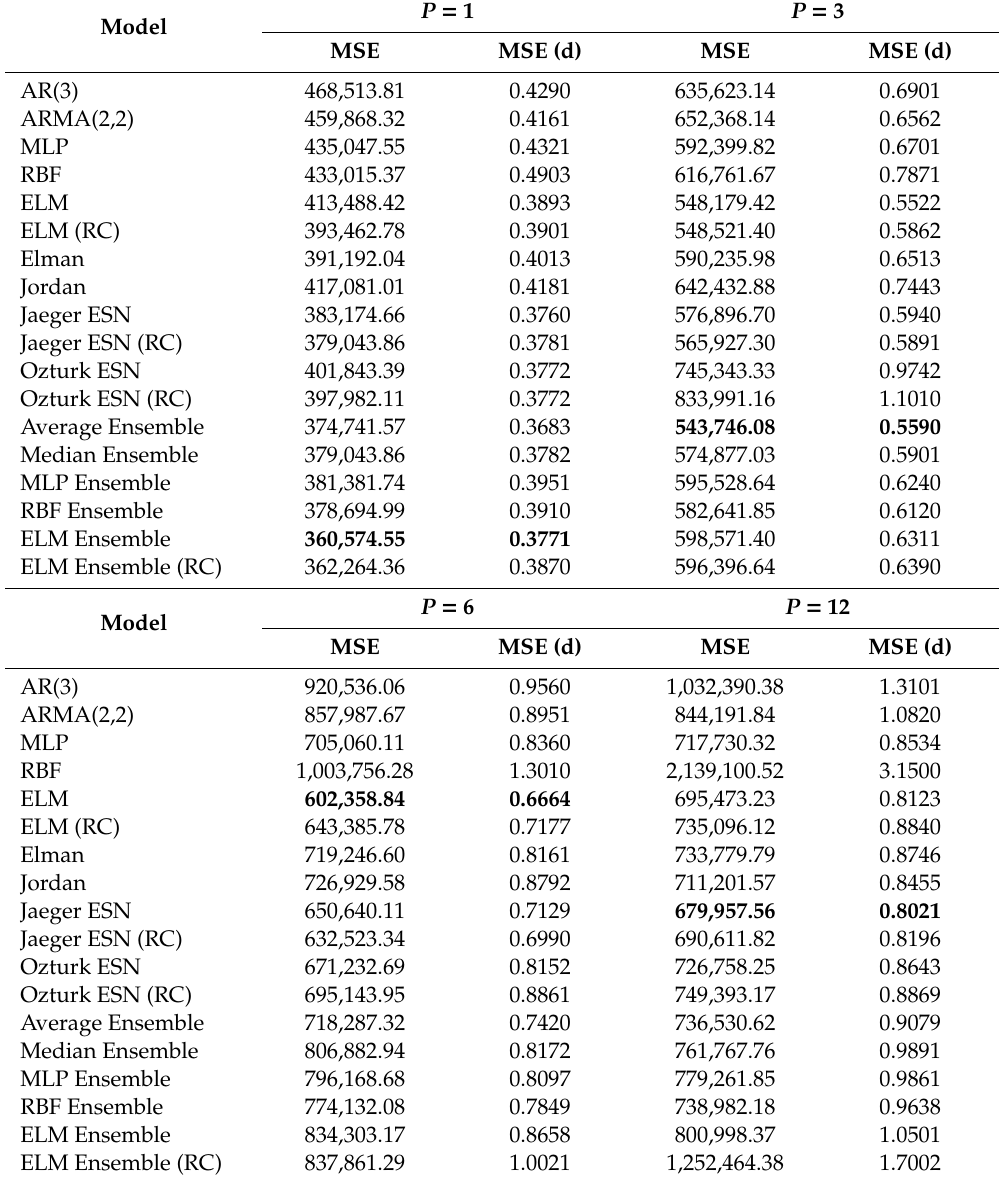
Table 2. Computational results for Á gua